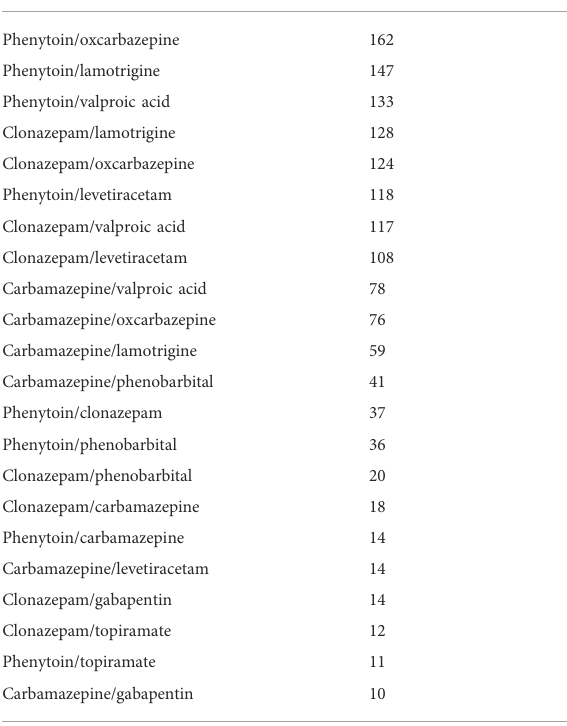
TABLE 1Number ofindividuals with co-exposure to twoor moreanti- seizure